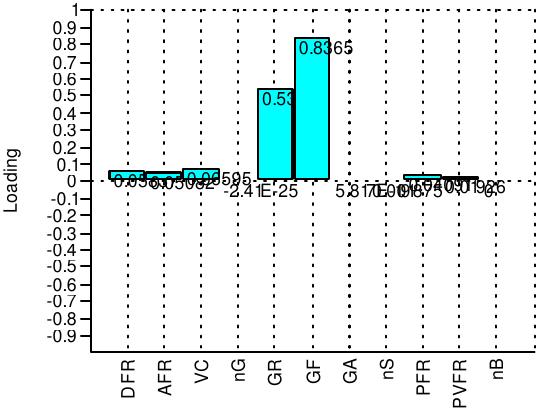
Fig. 8. PCA loadings for the meristics of the right side of wide and cultured Clarias gariepinu